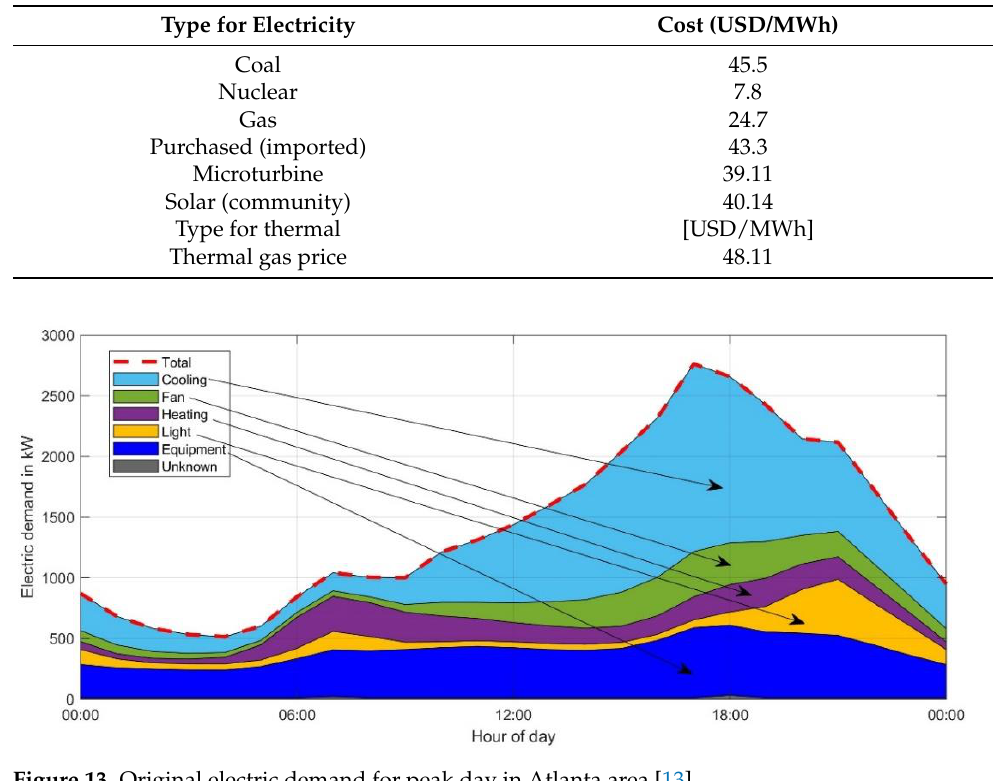
Figure 13. Original electric demand for peak day in Atlanta area [13].